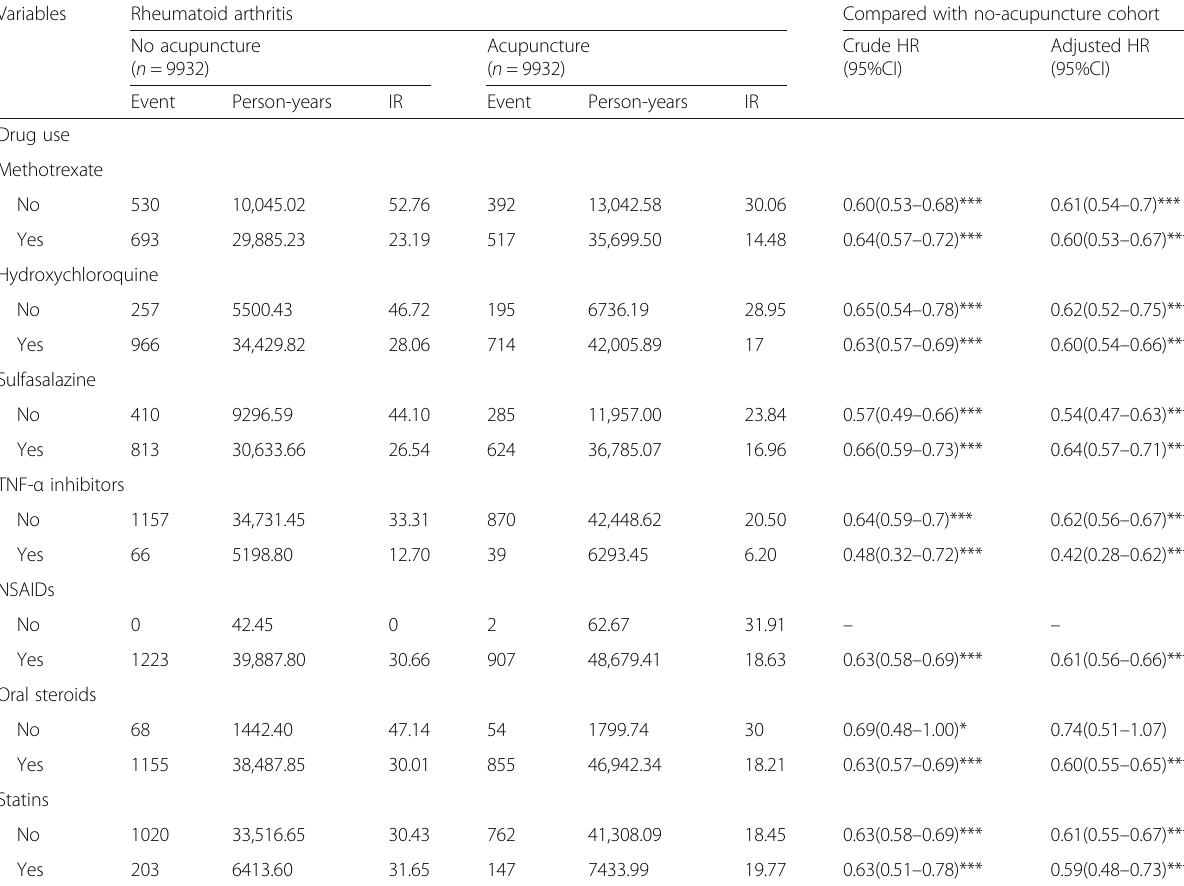
Table 3 Incidence rates, hazard ratio and confidence intervals for coronary heart disease in rheumatoid arthritis patients who did or did not receive acupuncture treatment, stratified by sex, age, comorbidity and drug use (Continued)